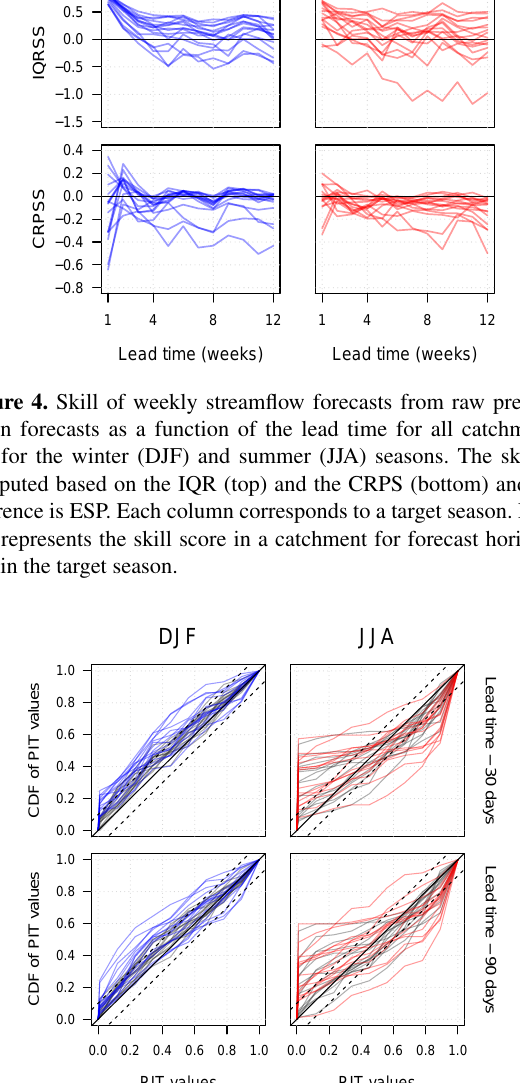
Figure 5. PIT diagram of streamflow forecasts from raw precipita- tion forecasts (coloured lines) and ESP (grey lines) for lead times of 30 days (top) and 90 days (bottom). Each column corresponds to a target season. Each line represents the PIT diagram in a catchment for forecast horizons within the target season. Dotted lines represent the ± 0.1 tolerance bands from the